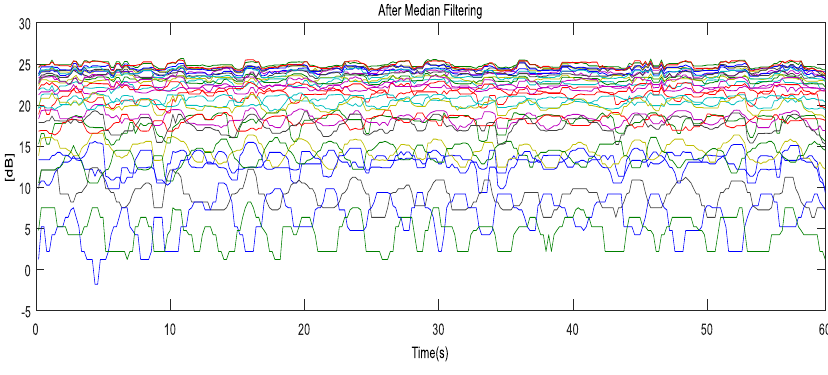
Figure 9. Filtered CFR for normal breathing.